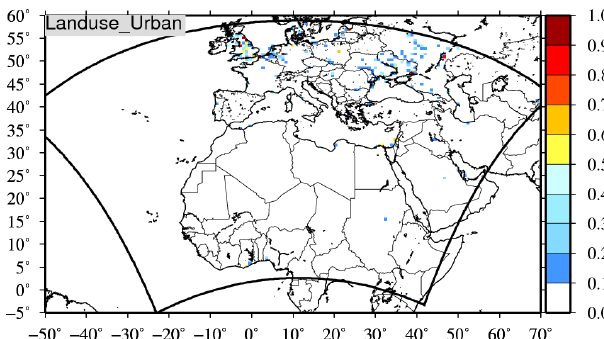
Figure 2. Map of the studied region with the modeled domain. The colors represent the percentage of urban and built-up surfaces in each model